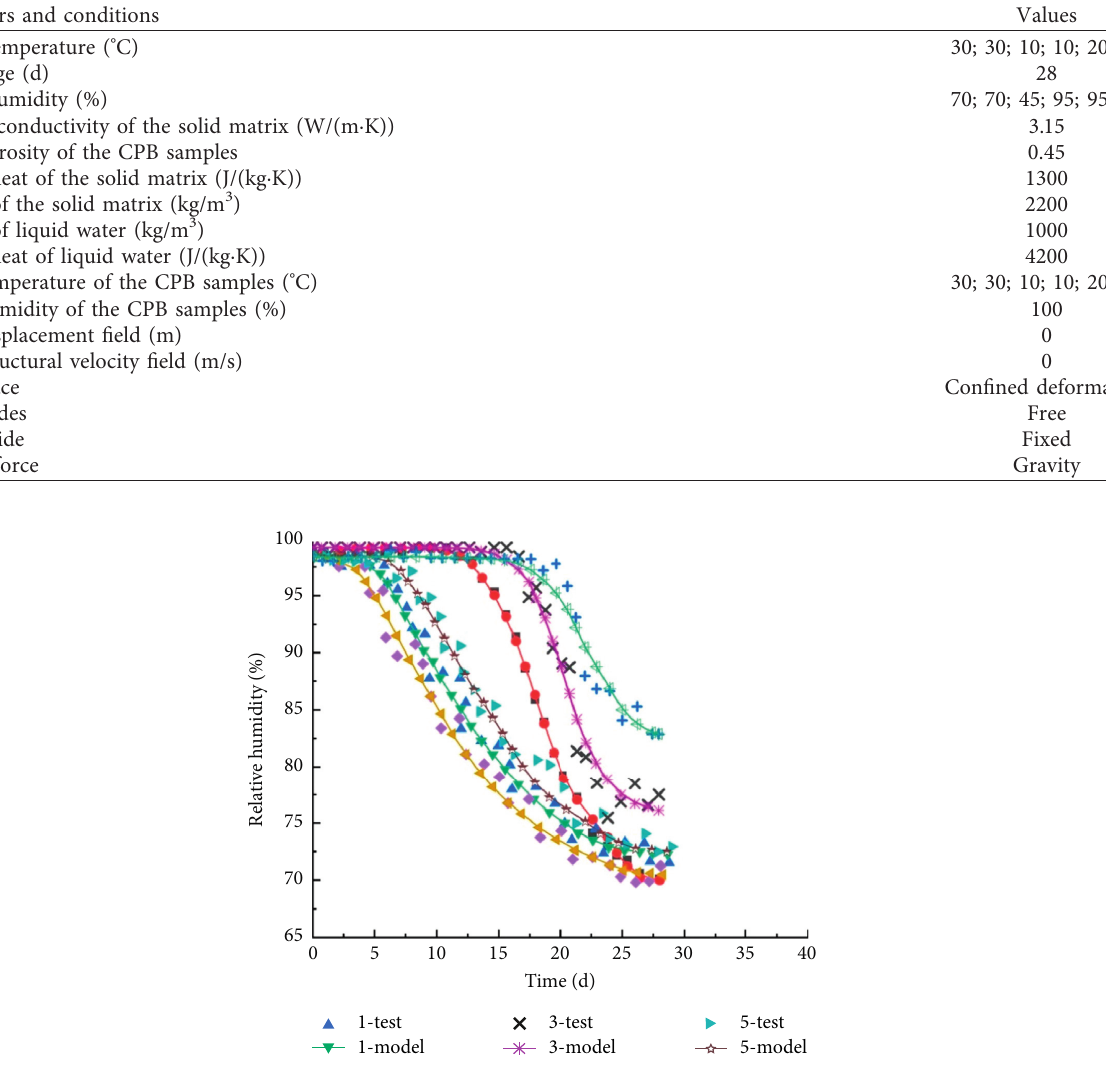
Table 2: Parameters and conditions used for model verification.